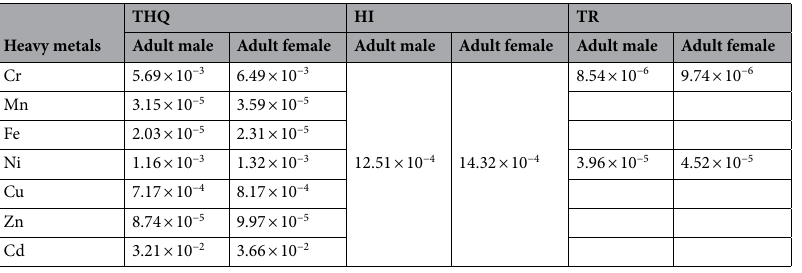
Table 7. Health risk assessment parameters THQ, HI, and